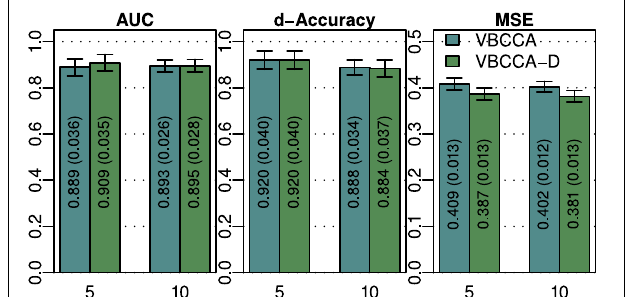
FIGURE 4 | AUC, d-Accuracy, and mean squared error (MSE) scores for the proposed method with and without using the approximate time series z( t ). The method are denoted by VBCCA ( z ( t ) used) and VBCCA-D ( z ( t ) not used). The simulation parameters are the same as in the first experiment, i.e., N = { 5 , 10 } , T = 500, P = 2, SNR = 0dB. All results are averages over 50 simulations with error bars indicating the 95% confidence intervals. The average scores are also shown as numerical values in the bar plot, where the values in parentheses are the size of one side of the confidence